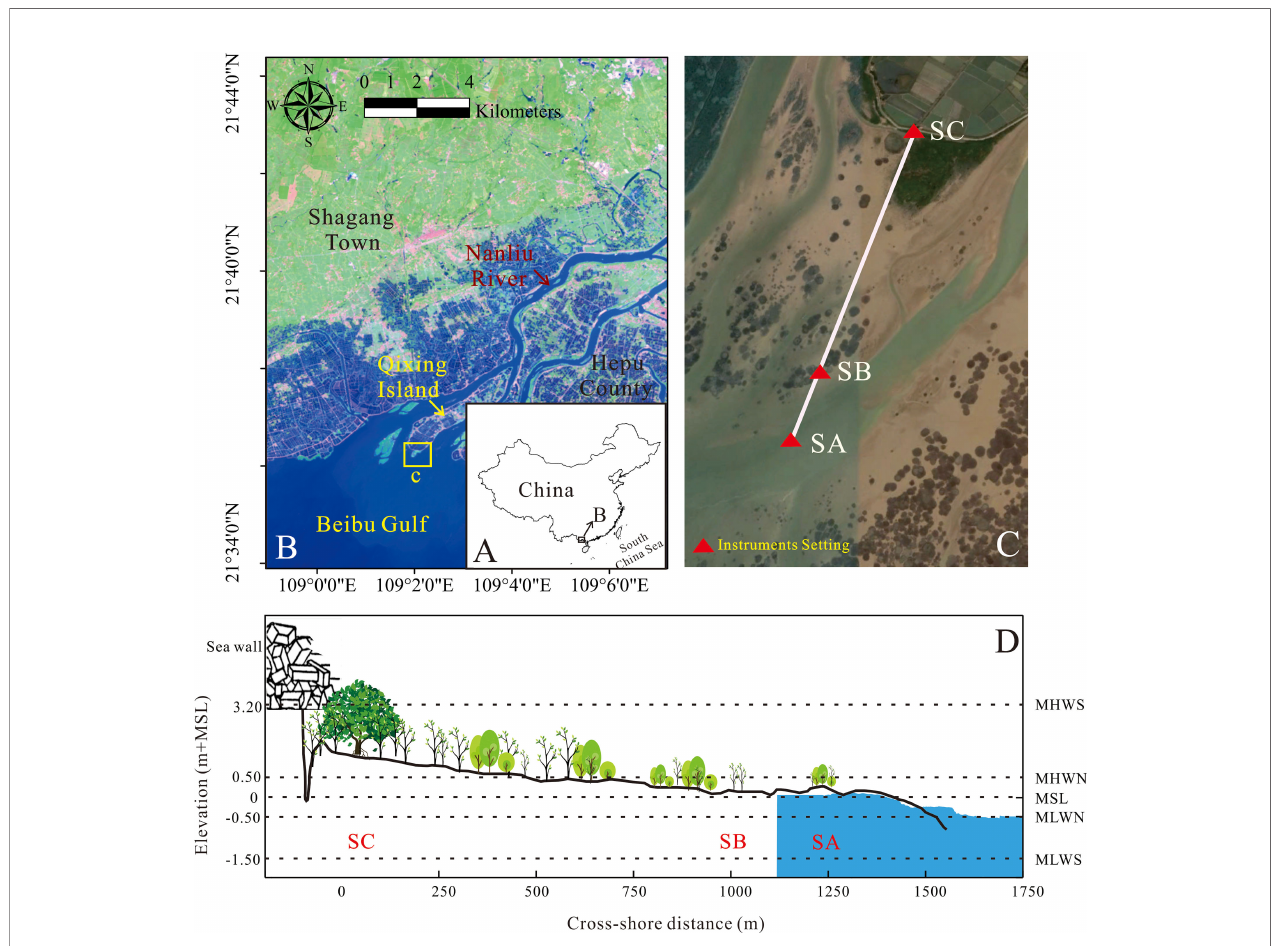
FIGURE 1 | (A) Map of the Beibu Gulf with its location in relation to China; (B) study area in relation to Hepu County, Beibu Gulf, and Nanliu River; (C) tripod setting location on the Aegiceras corniculatum tidal fl at; (D) elevation with respect to the mean sea level (MSL) of the cross-shore transects with relative distance from the inshore tripod, with instrument tripods and mixed age A. corniculatum . Tidal water levels are indicated on the right axis (MHWS, mean high water level at spring tide; MLWS, mean low water level at spring tide; MHWN, mean high water level at neap tide; MLWN, mean low water level at neap